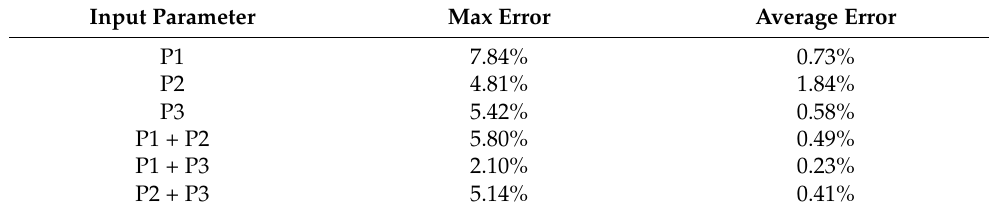
Table 5. Test result error summary.